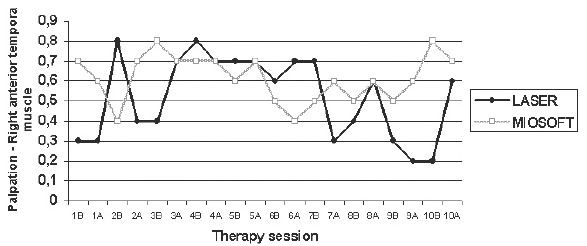
FIGURE 3- Mean palpation figures (from 0 to 3) of the right anterior temporal muscle, before and after each therapy